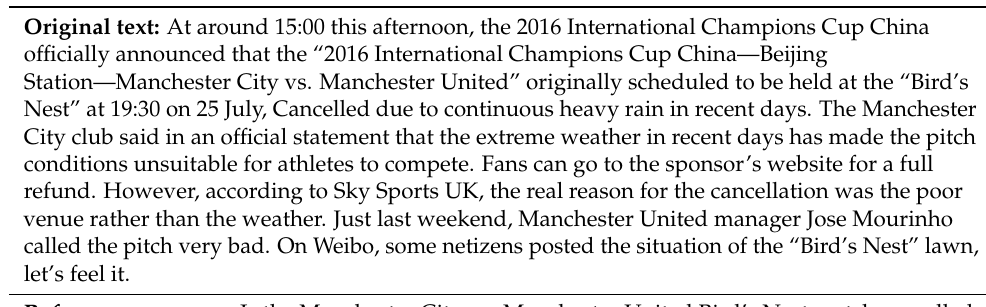
Table 7. Example of summaries generated on LCSTS